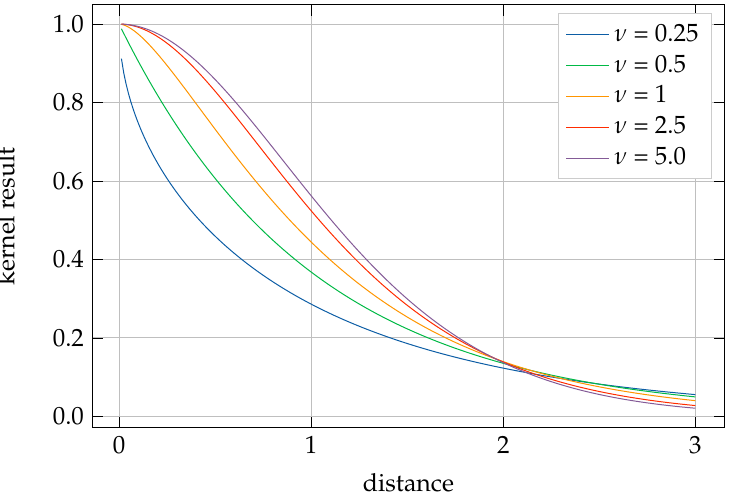
Figure 3. Exemplary Matern-kernel functions for the different realization of the parameter ν